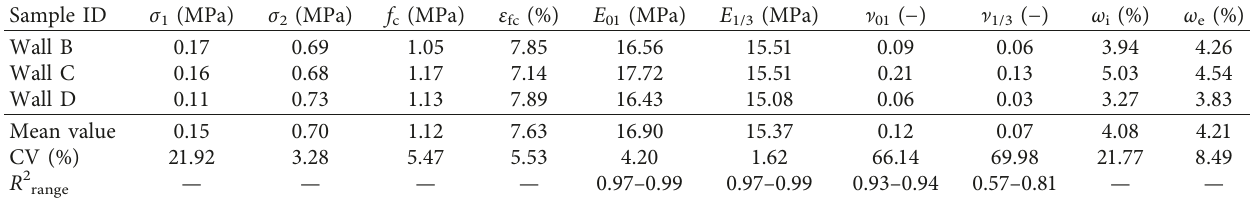
Table 3: For each specimen, compressive strength f c and related strain ε fc , elastic moduli and Poisson’s ratio computed at 0.6 and 1/3 f c ( E 01 , ] ] 01 and E 1/3 , 1/3 , resp.), and mean internal and external water contents ( ω i and ω e, , resp.) are reported. The compression stresses related to the formation of the first capillary cracks ( σ 1 , end of the first phase) and those related to the formation of diffuse cracks ( σ 2 , end of the second phase) are also reported (Figure